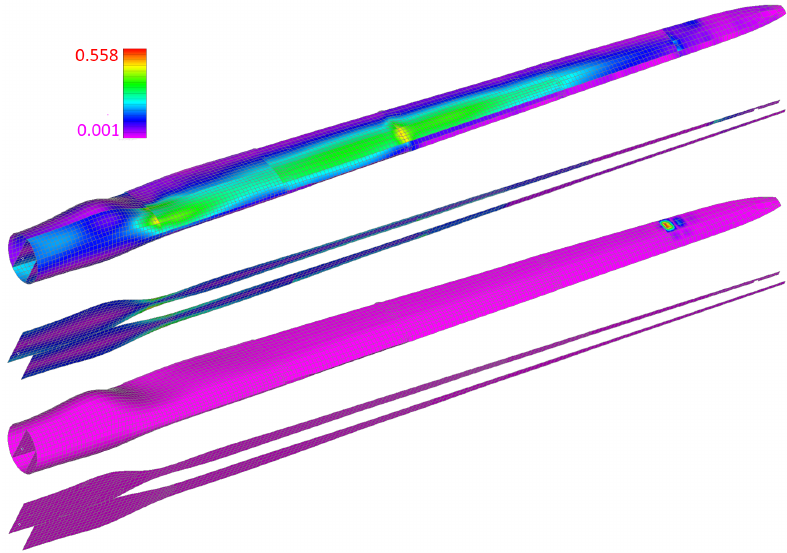
Figure 19. FEA fiber failure index and buckling eigenvector results for MOSOP3 solution extracted.